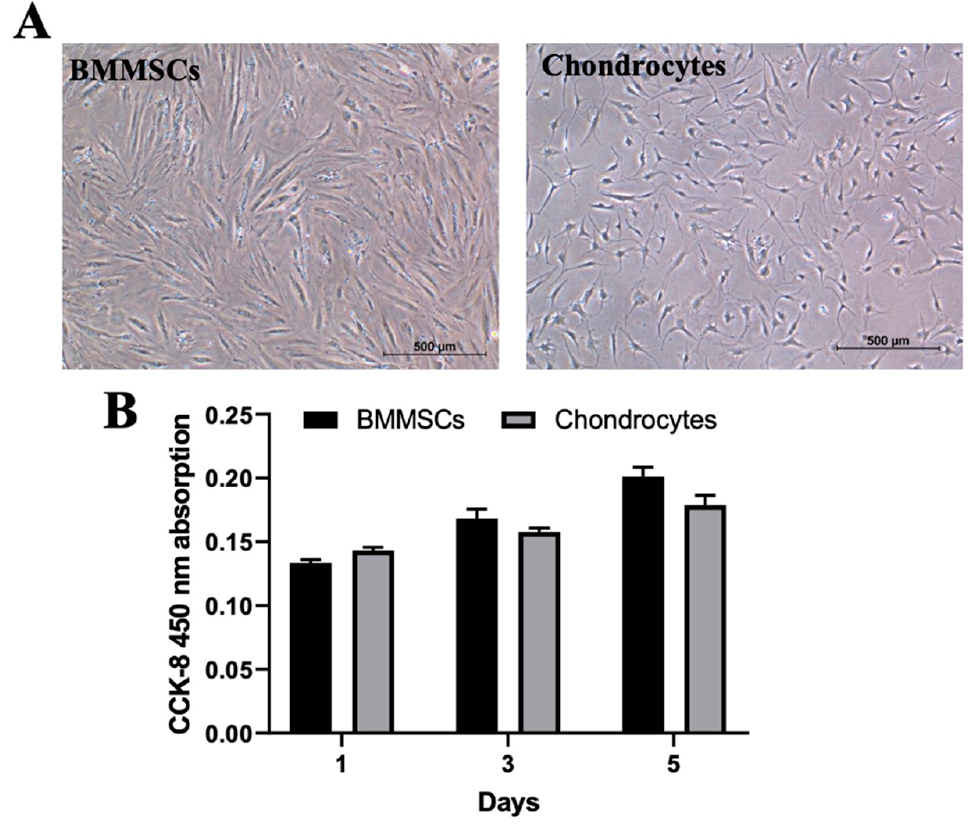
Figure 2. Characterization of BMMSCs and chondrocytes. ( A ) Light microscope micrographs of BMMSCs and chondrocytes, magnification: × 40; ( B ) Proliferation of BMMSCs and chondrocytes using CCK-8 kit and measuring absorption at 450